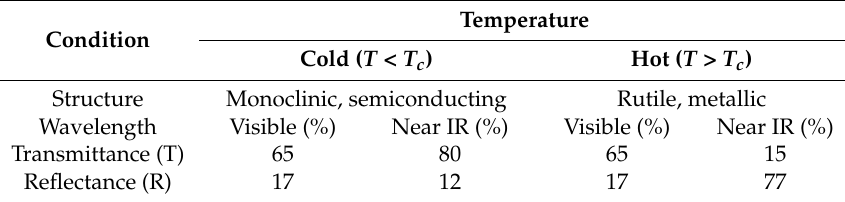
temperature ( T c